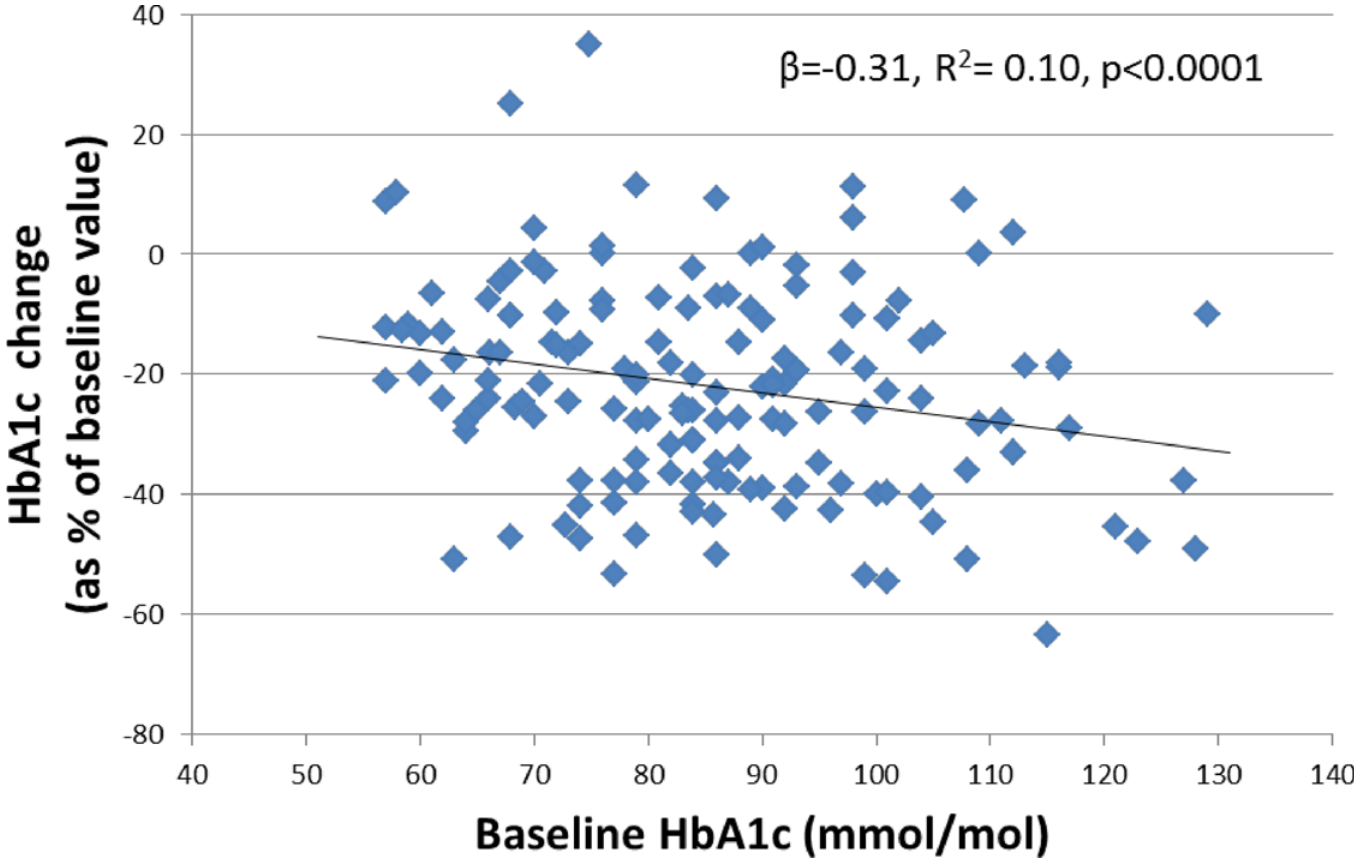
Fig 3. The relationship between Baseline HbA1c and post treatment HbA1c change after GLP-1RA therapy expressed as a percentage of baseline HbA1c.